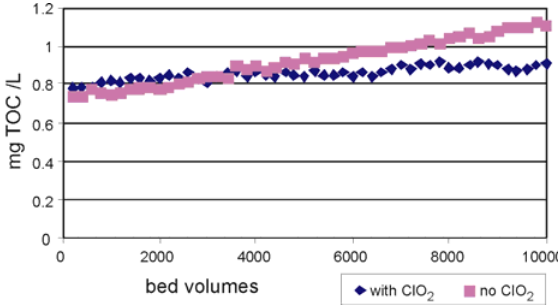
Fig. 4b. TOC concentrations in the GAC vegetal column vs . time in Fortore pilot